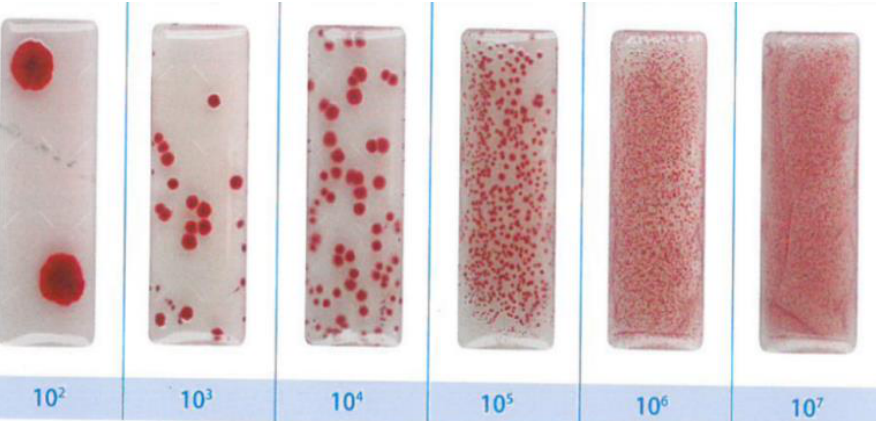
Figure 1. Quantification of biological load according to MicroKount ® specifications.